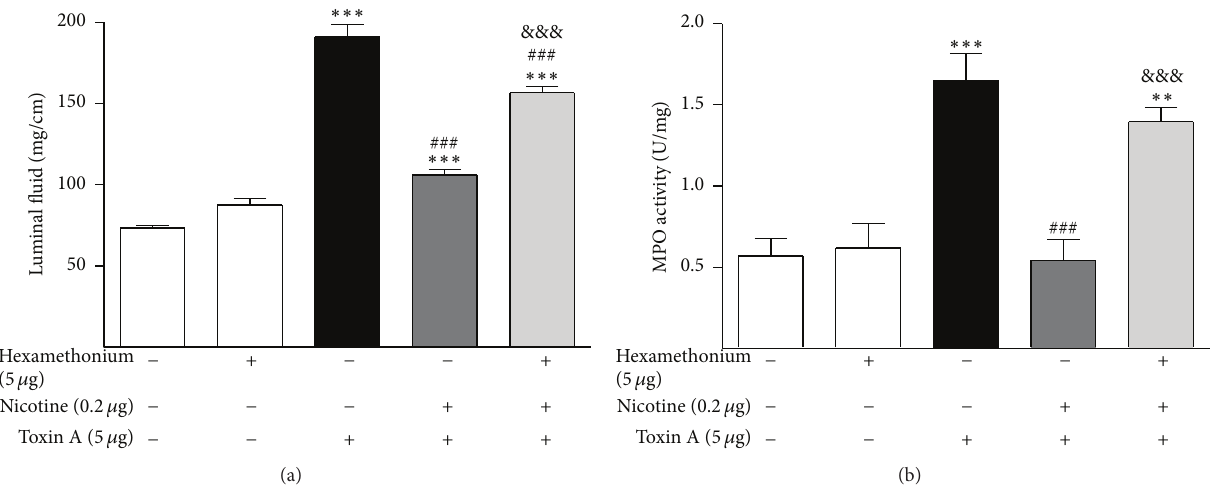
Figure 3: The anti-inflammatory effect of nicotine on the rat colon is mediated by nicotinic receptors because the specific nicotinic receptor antagonist, hexamethonium, significantly inhibited the protective effects of nicotine on toxin A-induced luminal fluid accumulation (a) and MPO content (b) in the colon. ∗∗ 𝑃 < 0.01 versus control; ∗∗∗ 𝑃 < 0.001 versus control; ### 𝑃 < 0.001 versus toxin A; &&& 𝑃 < 0.001 versus toxin A + nicotine; 𝑁 = 6 .